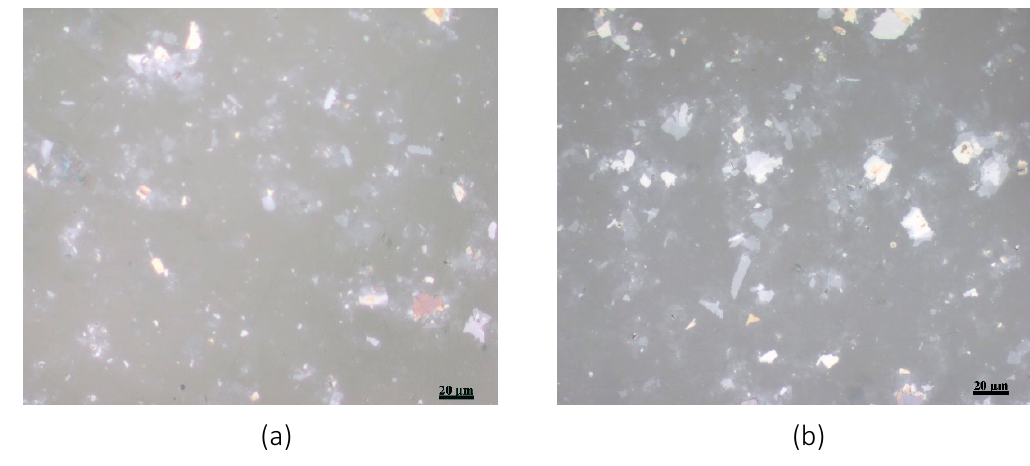
Figure 3. Two microscopic images of the GO film on top of COC wafer ( a ) before and ( b ) after the water boiling test.